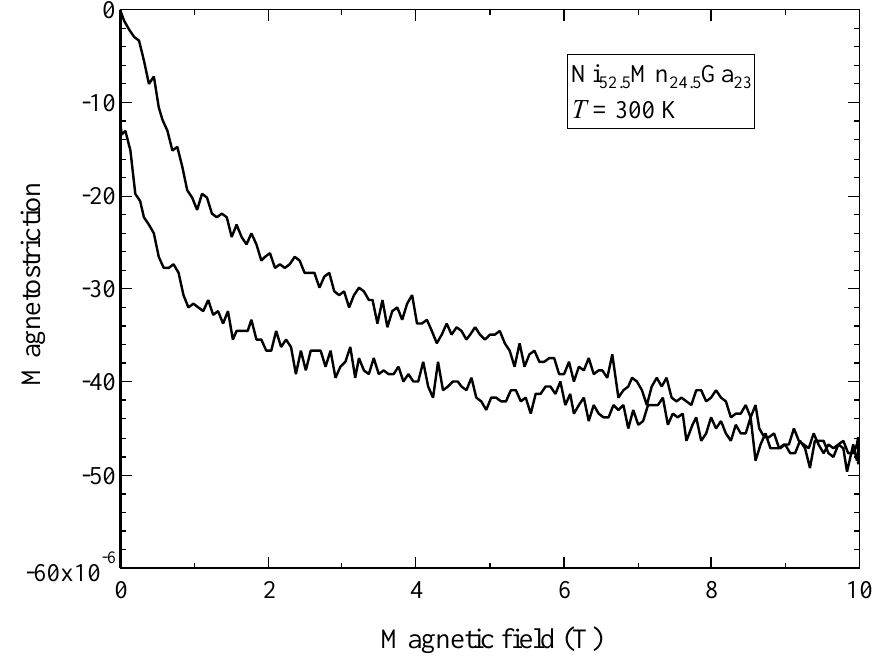
Mn Ga at 300 K in a static magnetic field of up to 10 52.5 24.5 23